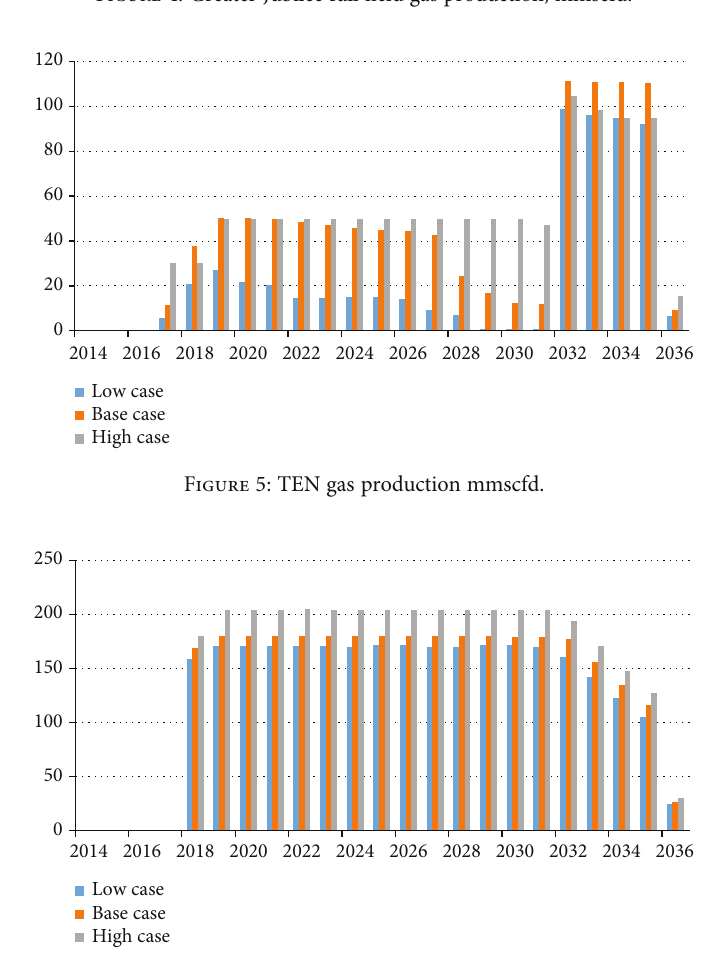
Figure 6: Sankofa and Gye Nyame gas production mmscfd.